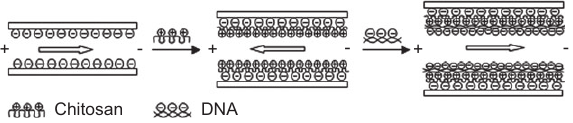
Figure 2 Modification of chitosan/DNA-modified PDMS microchip (Liang et al. 2008